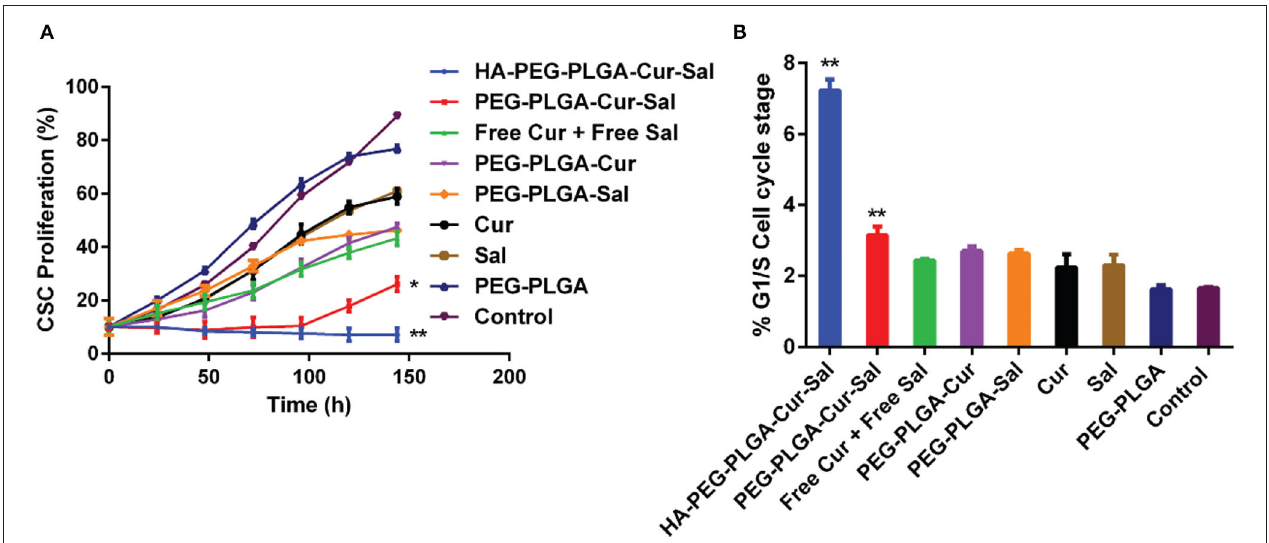
FIGURE 3 | (A) Cell proliferation study of HA-PEG-PLGA-Cur-Sal, PEG-PLGA-Cur-Sal, PEG-PLGA-Cur, PEG-PLGA-Sal, PEG-PLGA, Cur, and Sal against CSCs. (B) Cell cycle arrest study of HA-PEG-PLGA-Cur-Sal, PEG-PLGA-Cur-Sal, PEG-PLGA-Cur, PEG-PLGA-Sal, PEG-PLGA, Cur, and Sal against CSCs. Values are means ± standard deviations ( n = 5, S.D.) (* p < 0.05, ** p < 0.01).